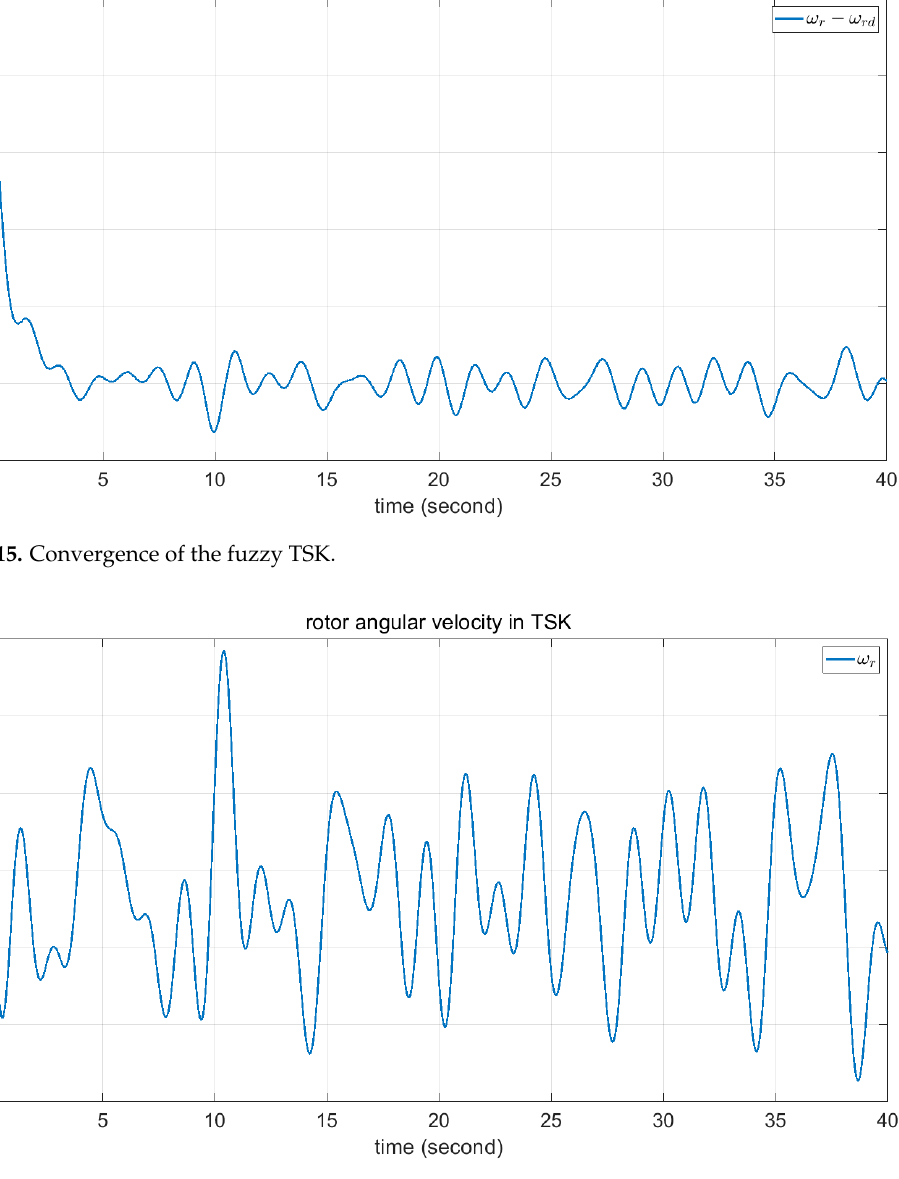
Figure 16. Angular velocity of the rotor in fuzzy TSK.